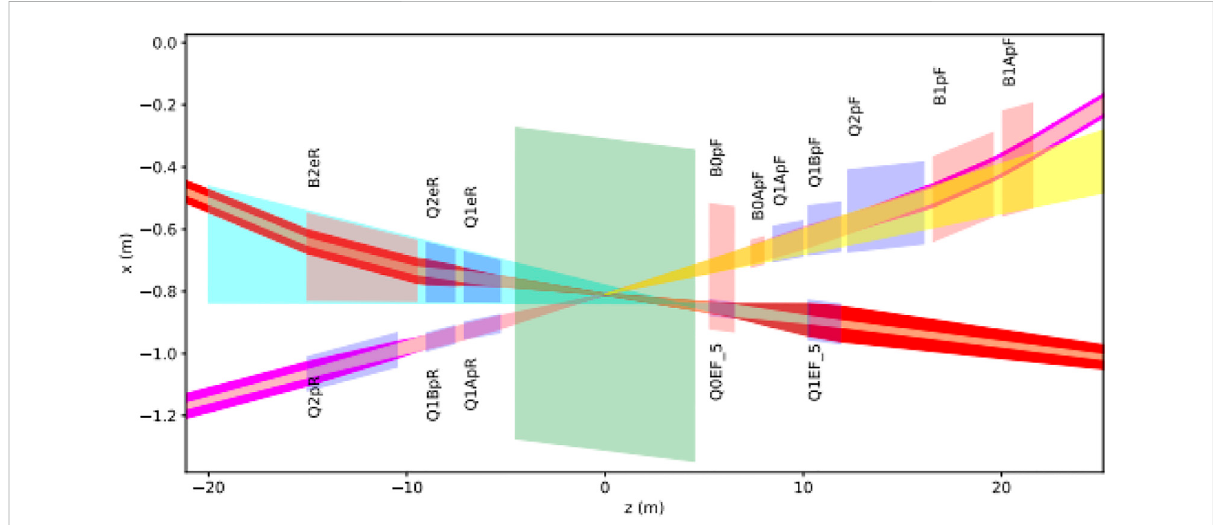
FIGURE 4 IR1layout.Thecentraldetectorisshowninlightgreen,thehadronandelectronbeamsareshowninmagentaandlightredrespectively.Magnet apertures are shown in light red for dipoles or light blue for quadrupoles. The forward neutron cone is shown in